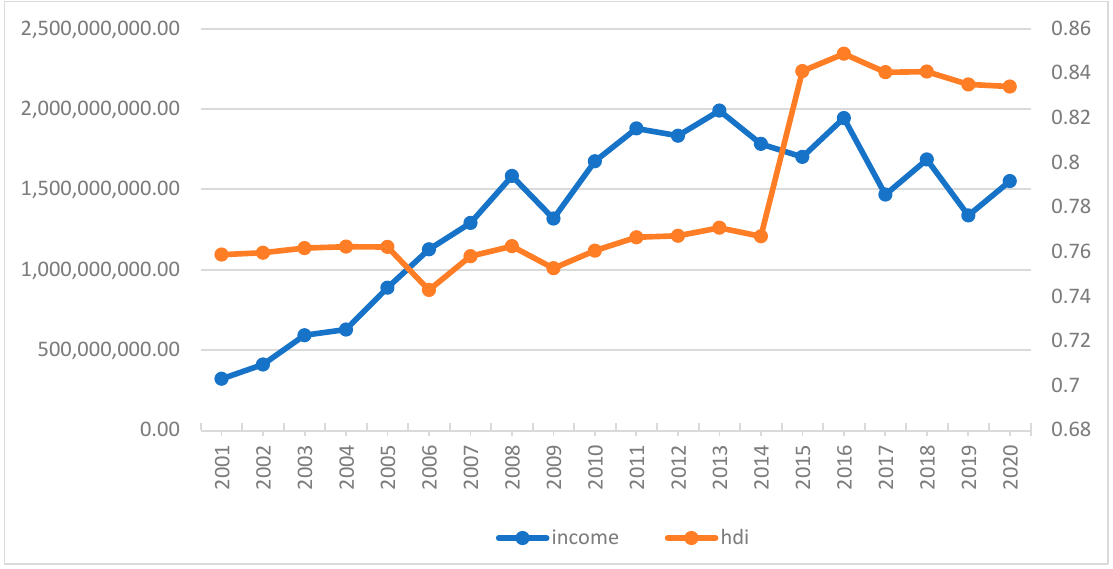
Figure 6. RHDI and FRA Ege 2000–2021. Source: Turk Statistical Institute.